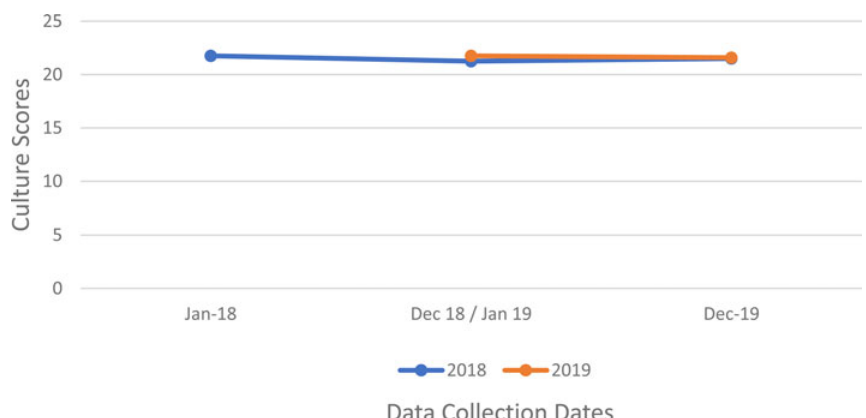
Fig. 5. Culture Mean Scores for 2018 & 2019